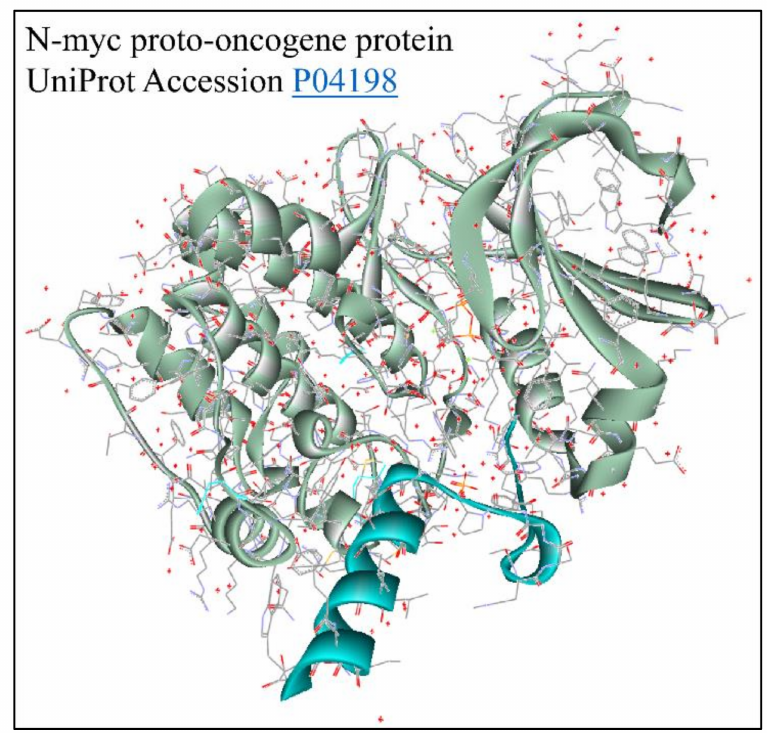
Figure 14. The predicted 3D structure of the MYCN protein with UniProt accession Nr. P04198 [73] (protein was visualized with Accelrys Discovery